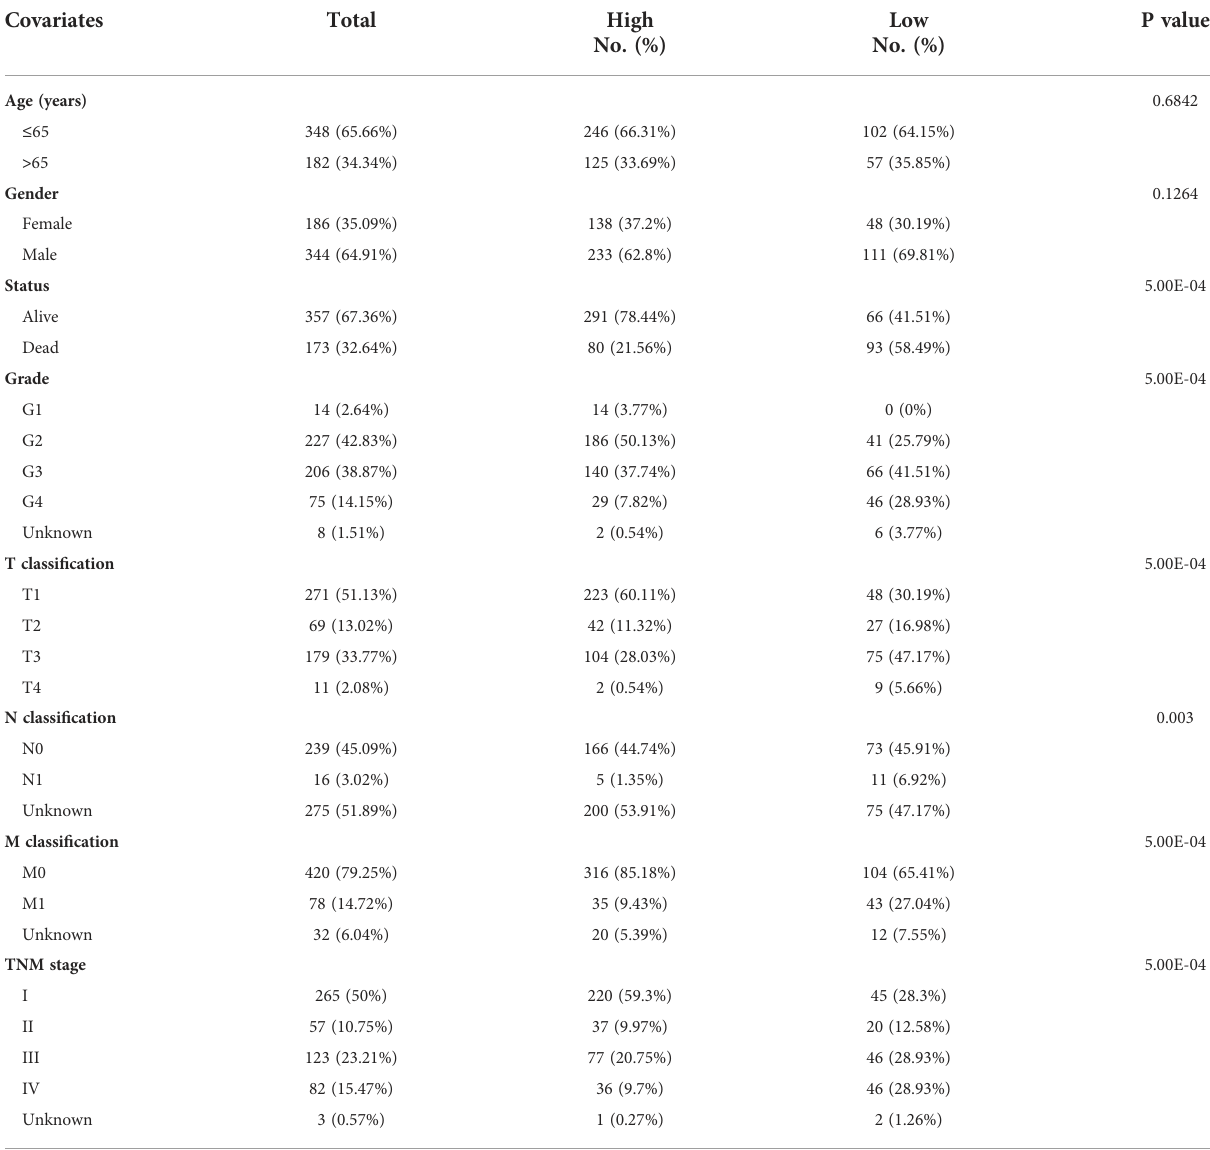
TABLE 1 Relationship between cuproptosis score and clinicopathological features of KIRC in TCGA.